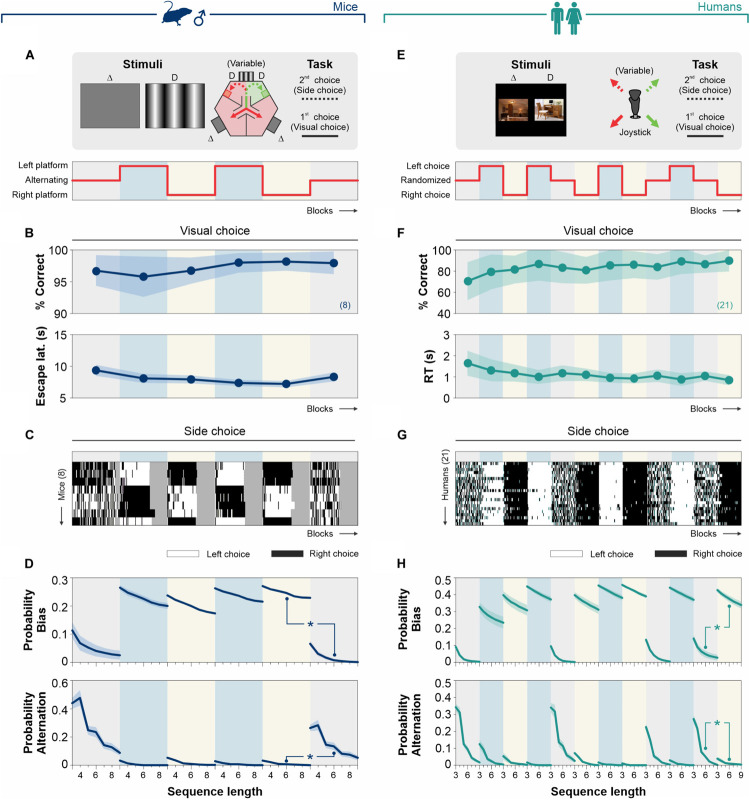
Reinforcement of biased and alternating choices. Task structure with a volatile (alternating reinforcement) or with a stationary (left or right reinforcement) rewarding landscape for mice (navy blue, A) and humans (dark cyan, E). (B)% Correct choice and escape latencies of the mice obtained with a 100% contrast stimulus along with blocks of trials with alternating (10% gray background), left (sky blue), or right (lemon yellow) reinforcement. (C) Colormaps of side-choices of individual male mice, with black (right choices) or white (left choices) rectangles across experimental manipulations. This experiment involved six epochs of 520 trials acquired along 12 days/epoch. (D) Probability of occurrence for biased (upper row) and alternating (lower row) probabilities as a function of sequence length for the different experimental blocks. (F)% Correct choices and response times obtained with stimuli with high discriminability (i.e., k = 0) along with blocks with balanced randomized (10% gray background), left (sky blue), or right (lemon yellow) reinforcement. (G) Side-choice colormaps for human participants, along with the different training blocks. (H) Probabilities for biased (upper row) and alternating (lower row) choices. Number of subjects in parentheses.